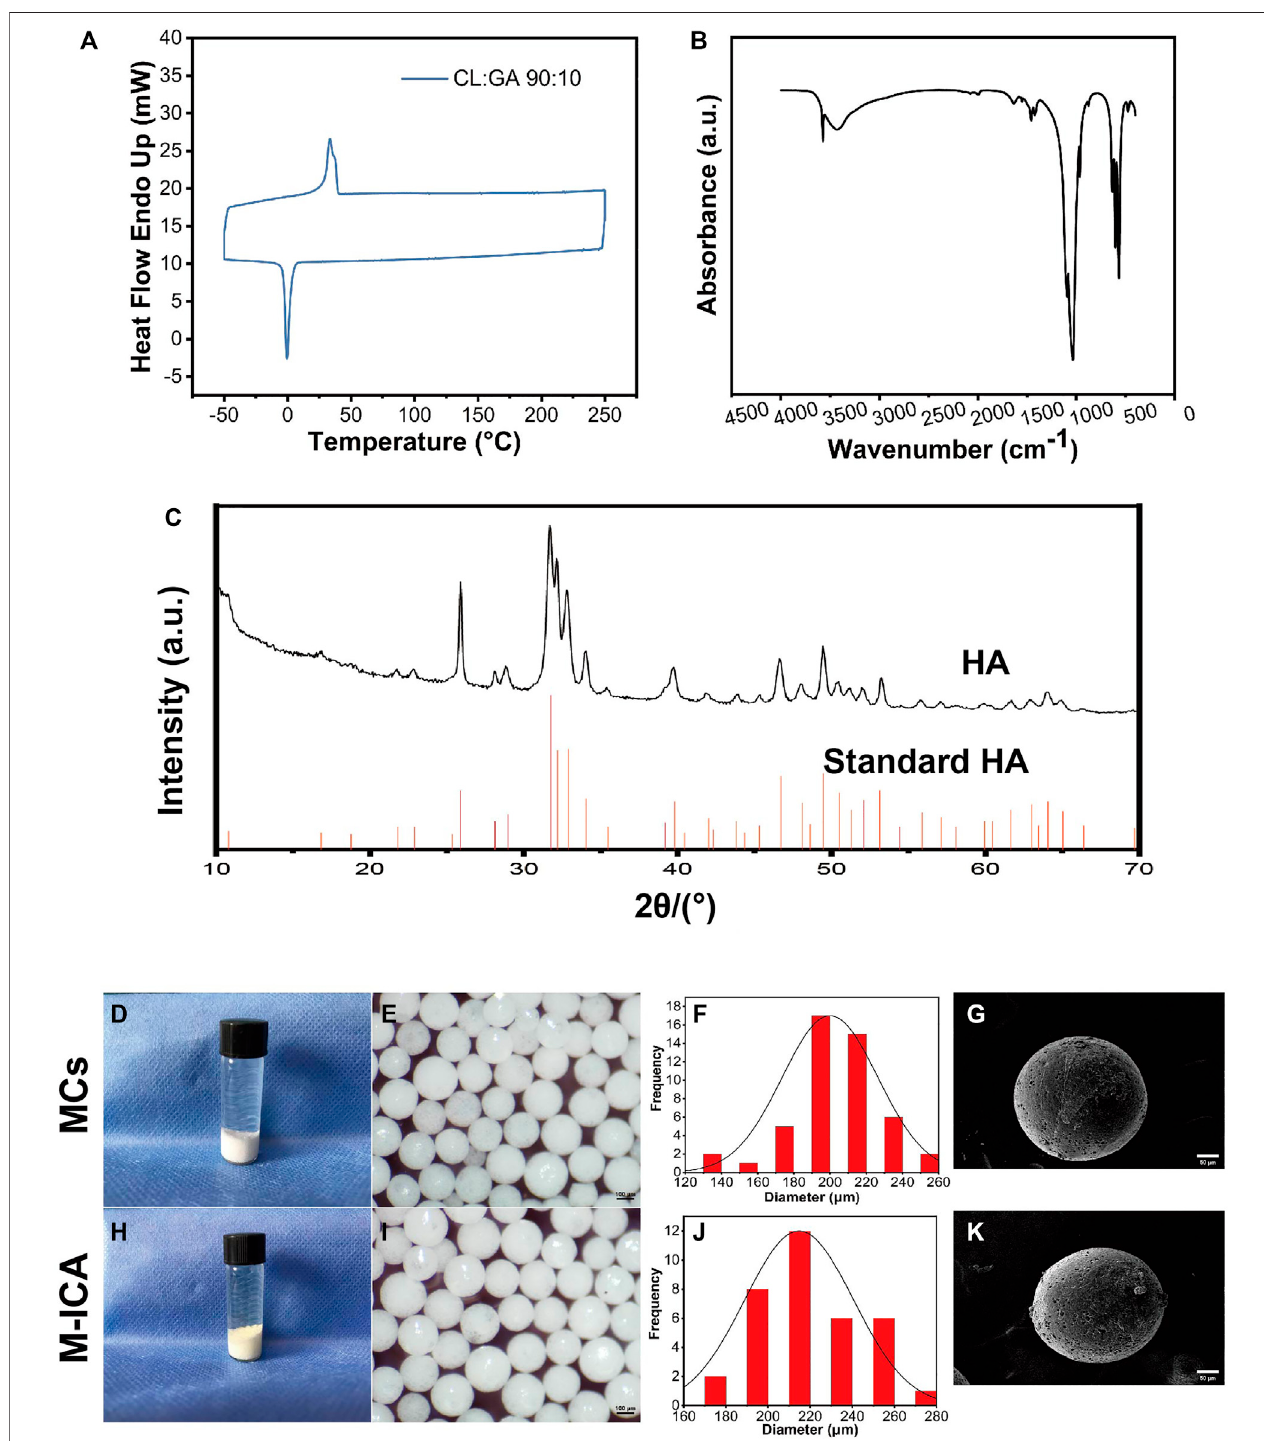
FIGURE 2 | (A) DSC thermogram of PGCL. (B) FTIR spectra of HA. (C) XRD pattern of HA. (D – K) Gross observation (D,H) , macroscopic images (E,I) , size distribution (F,J) , SEM images (G,K) for MCs and M-ICA (Scale bar = 100 μ m for e and i, 50 μ m for g and k).